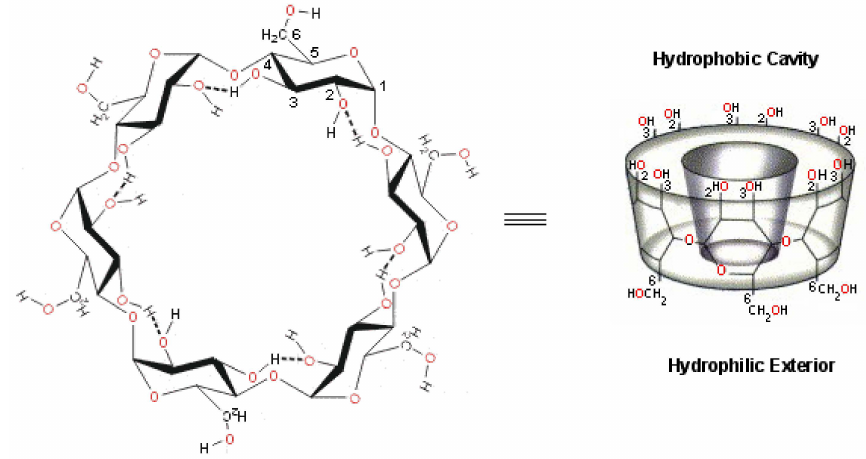
Figure 2. The cyclic oligosaccharide cyclodextrin